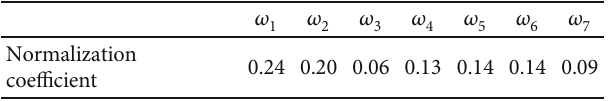
Table 4: Weight normalization coe ffi